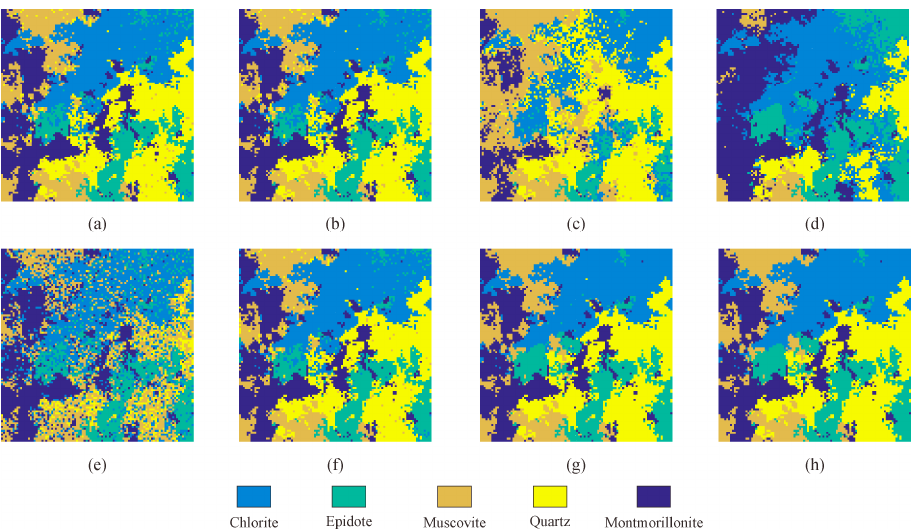
Figure 11. Comparison of classification results using different methods under the synthetic dataset with an SNR of 20 dB. ( a ) K-Means; ( b ) GMM; ( c ) SAM; ( d ) SVM; ( e ) SXGBoost; ( f ) AcPCKMeans; ( g ) SSAAE; ( h ) Reference.